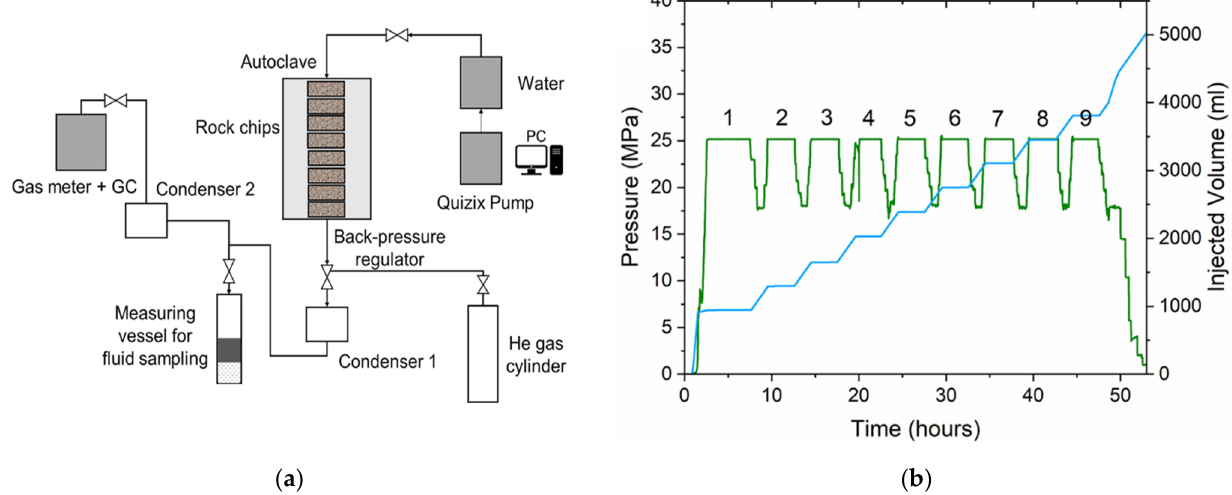
Figure 1. ( a ) Experimental set-up scheme; ( b ) injection pressure (green) and cumulative water volume (blue) profile.